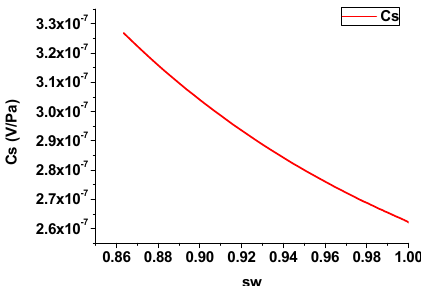
Figure 3. Variation of streaming potential coupling coefficient with saturation (bubbly flow).